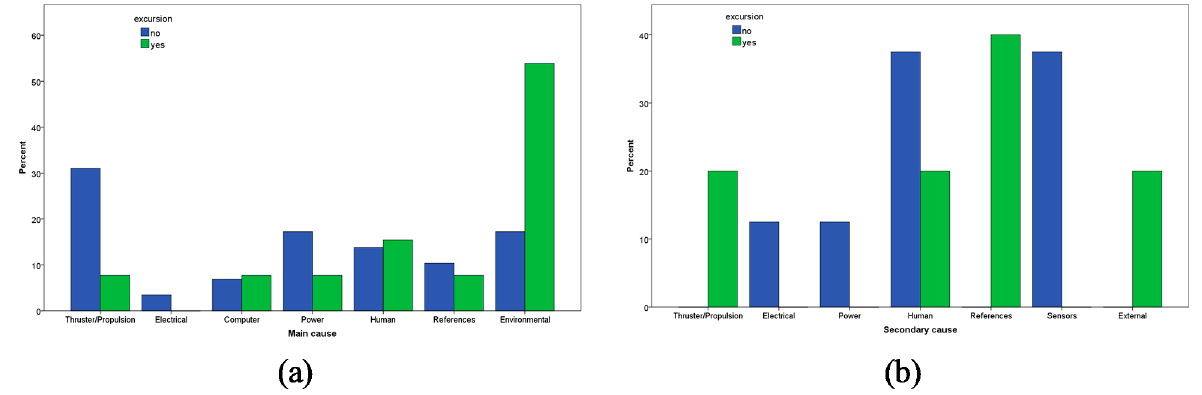
Figure 3. Distribution of incidents as a function of main ( a ) and secondary ( b ) cause stratified by whether excursion occurred.